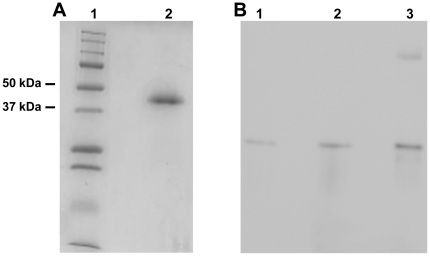
Protein purity and Western blot analyses.(A) 12% reduced SDS-PAGE showing purity of the purified Cbl-binding protein from mouse submaxillary glands. Lane 1) marker; Lane 2) purified mouse TC (see Materials and Methods for details). (B) Western blot employing anti-mouse antibodies on proteins separated by 10% native PAGE. Lane 1) approx. 60 fmol purified mouse TC (approx. 40kDa); Lane 2) extract of the Cbl-binder from mouse submaxillary glands corresponding to a total amount of Cbl+UB12BC of 64 fmol; Lane 3) mouse serum corresponding to a total amount of Cbl+UB12BC of 72 fmol.